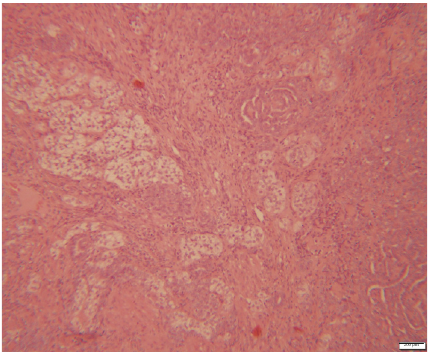
Figure1:H&Emicroscopicimageofthepolypwhichwascomposed of elements resembling ovarian sex cord tumors, including solid areas, glomeruloid structures, and small nests.